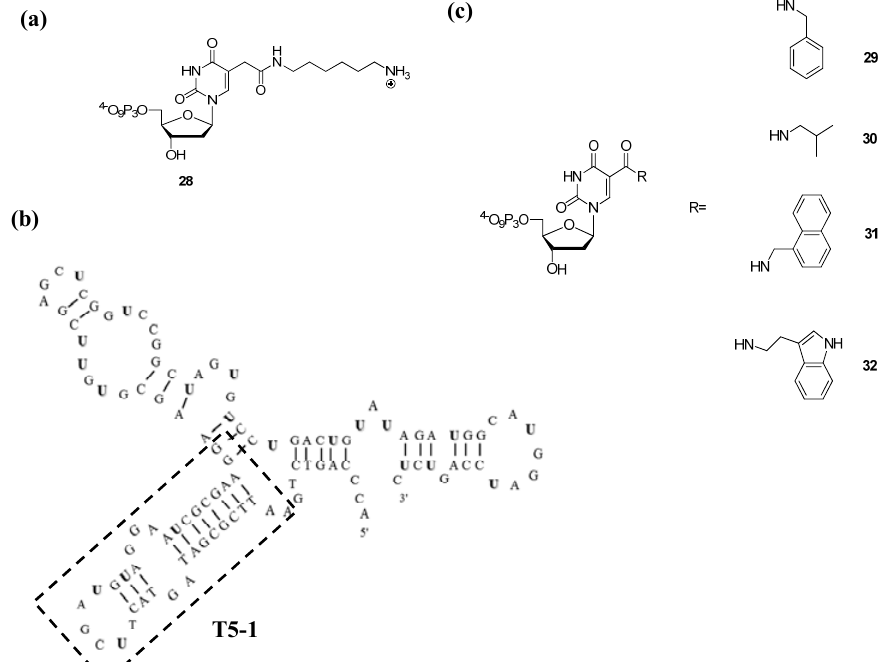
Figure 6. ( a ) Chemical structure of the amine-modified dUTP; ( b ) Sequence